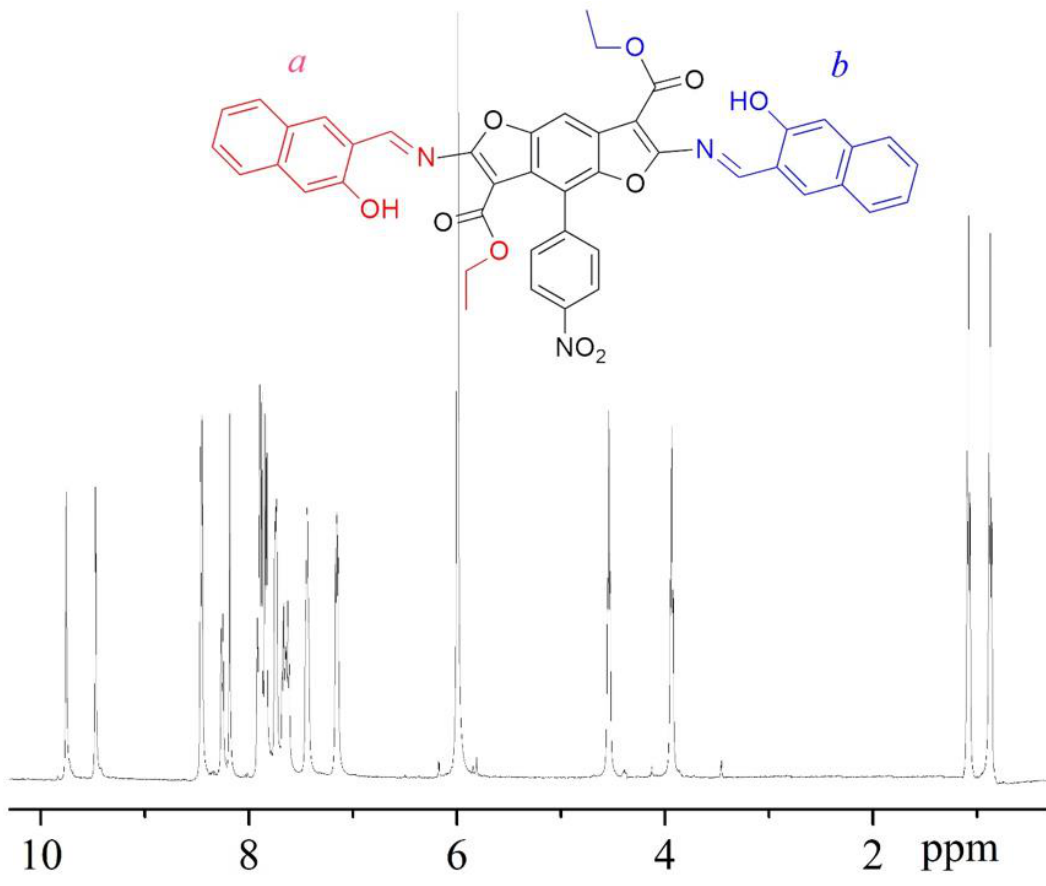
Figure 1. 1 H NMR of NBDF in 1,1,2,2-tetrachlorethane d2.